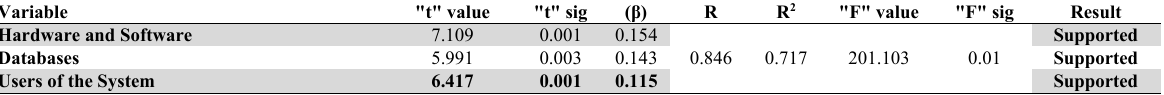
Result of Multiple Regressions test